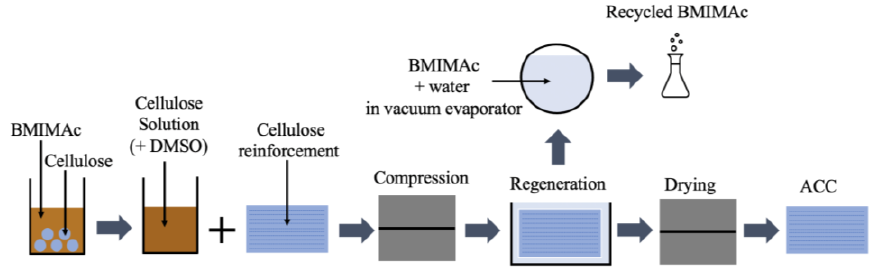
Figure 4. Illustration of the two-step